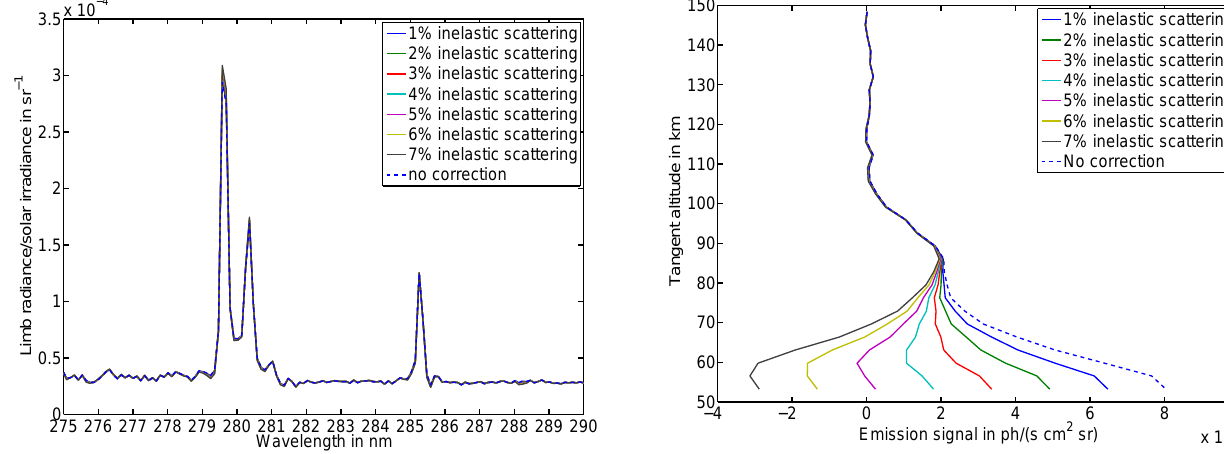
Fig. 7. Result of the Ring effect correction for a tangent altitude of 90km for the ratio I/F . The background signal is low at this altitude and the Ring effect correction is only very small.